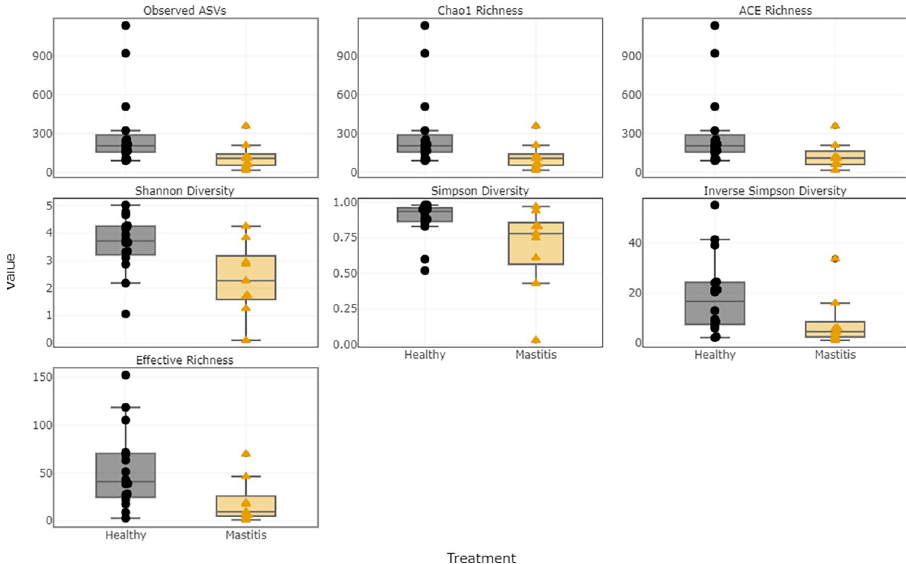
Fig 9. Distribution of alpha diversity measures in relation to sample groups for the 16S rRNA.